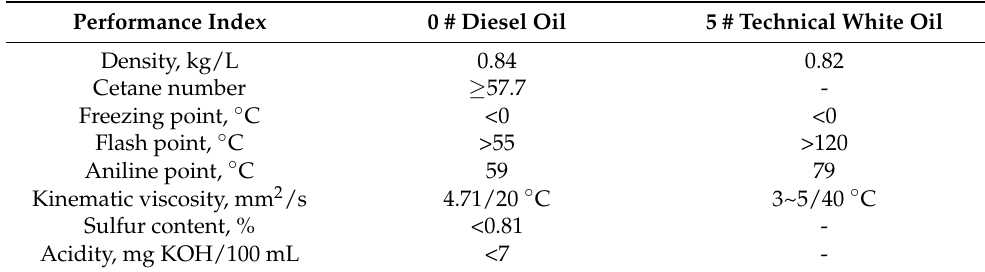
Table 9. Main performance parameters of the base